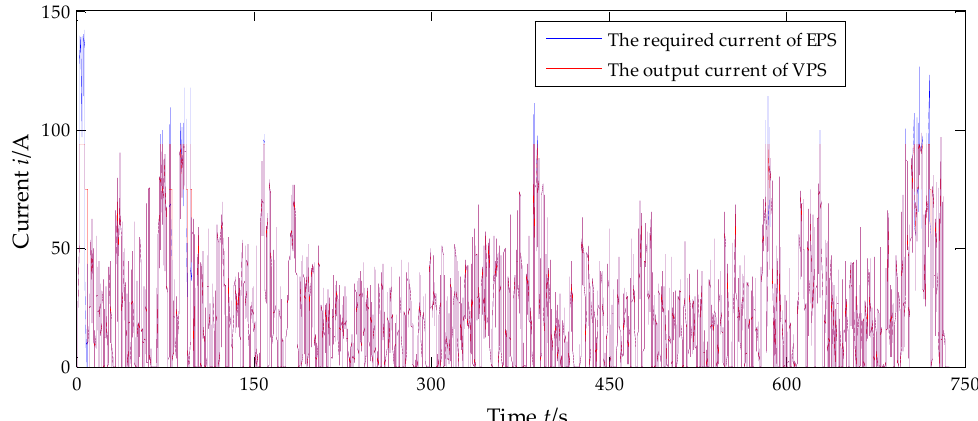
Figure 11. The comparison between the required current of EPS and the optimized output current of vehicle power supply (VPS).